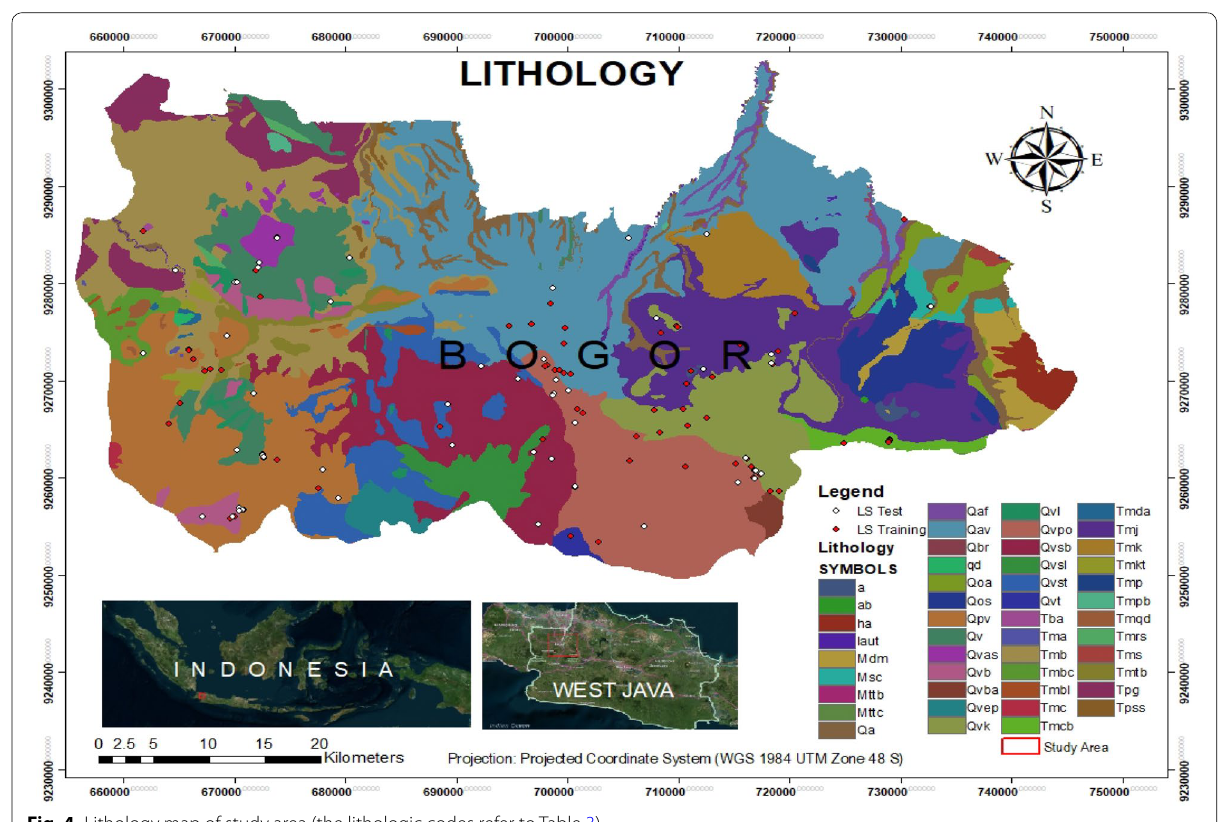
Fig. 4 Lithology map of study area (the lithologic codes refer to Table